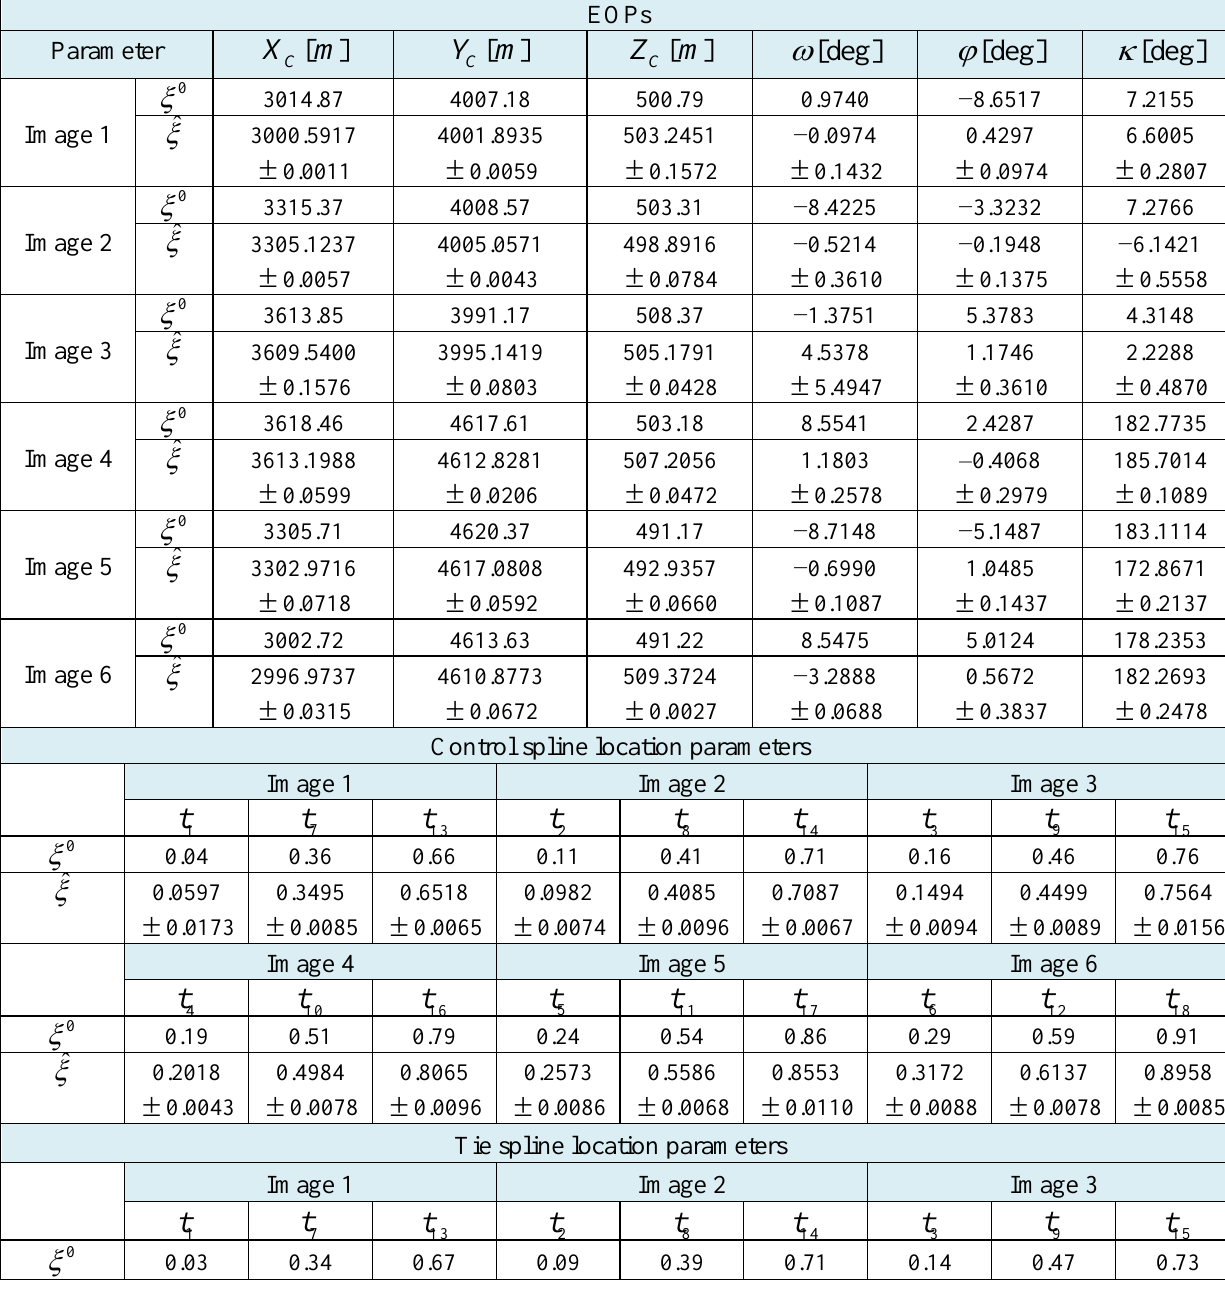
Table 7. EOP, control, and tie spline parameter